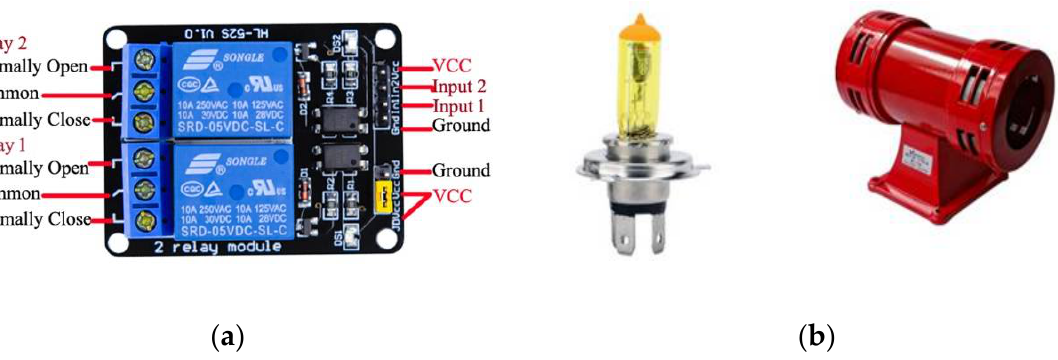
Figure 7. ( a ) Two-channel relay module with pinouts [66]; ( b ) golden yellow light bulb and siren.